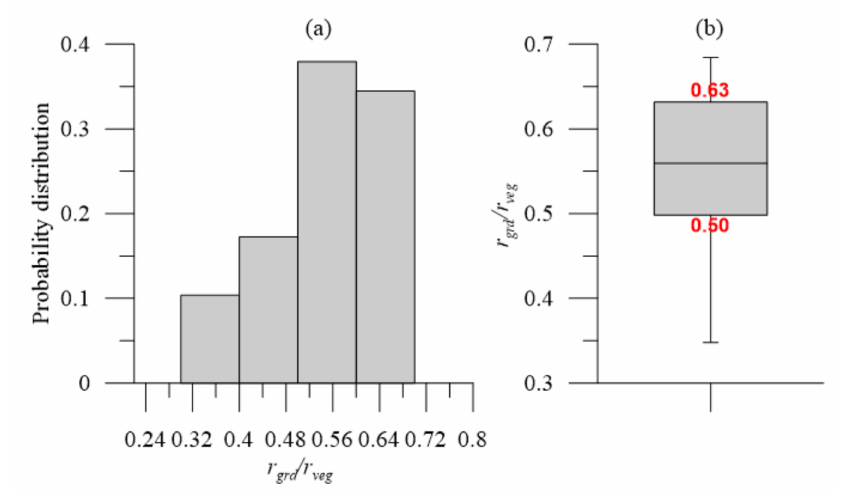
Figure 6. Spectral ratio of soil and vegetation ( r grd / r veg ) indicated as ( a ) histogram and ( b )